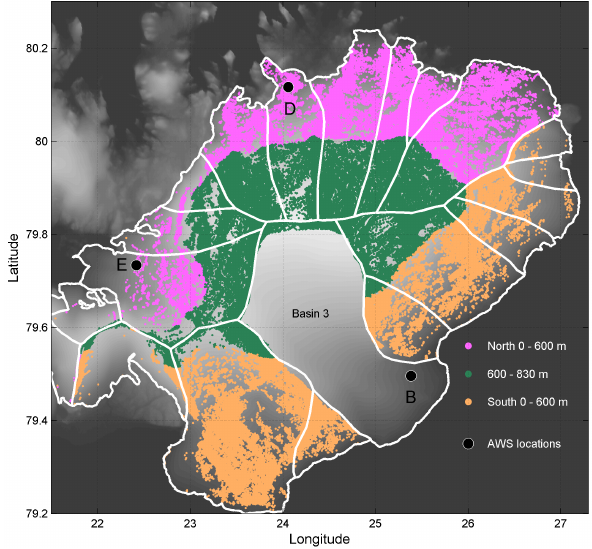
Figure 10. The different basins on Austfonna are illustrated by the white lines. Data from Basin 3, which has surged during the CryoSat-2 time period, have been removed and studied separately. The remaining CS2 data set has been split into the areas shown in different colours above, and the temporal height change plotted for both a monthly and a winter-to-winter height change in Fig. 11 below. The positions of the three automatic weather stations are marked E, D and